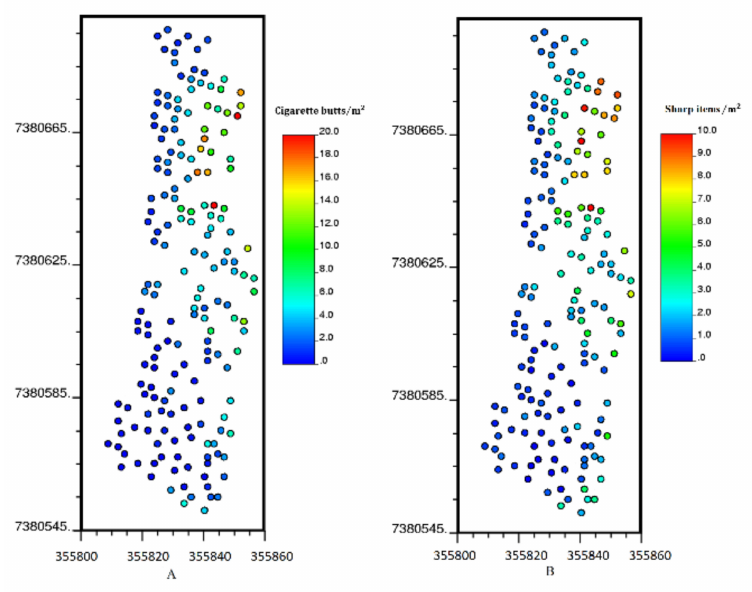
Figure 6. Location maps of training data: ( A ) cigarette butts, ( B ) sharp